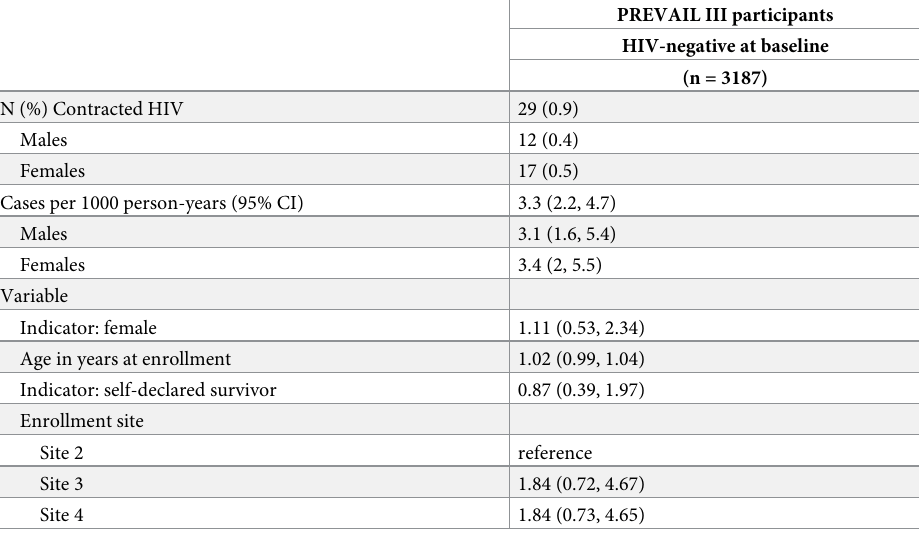
Table 2. Adjusted hazard ratios for HIV infection during PREVAIL III follow-up.